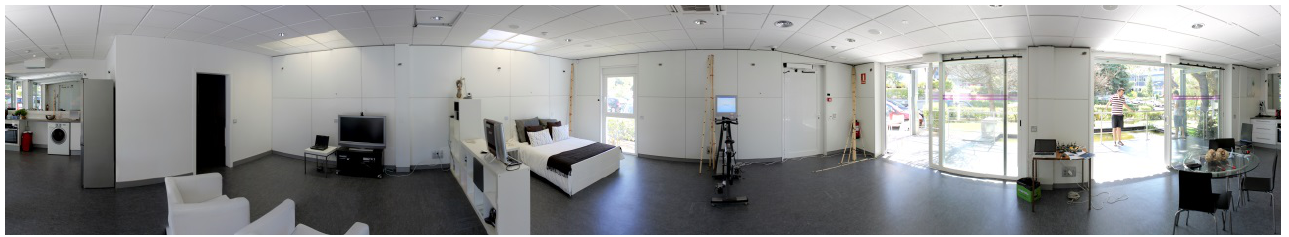
Figure 2. The overall view of the user area of the Smart House Living Lab.